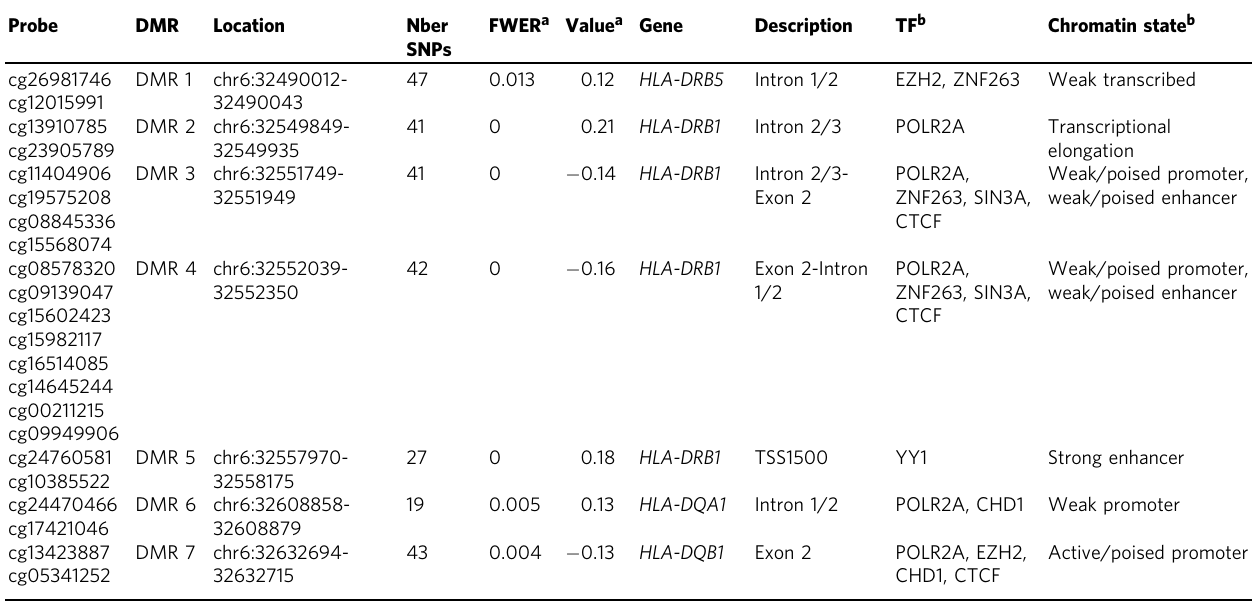
Table 1 DMRs that mediate genetic risk in multiple sclerosis Probe